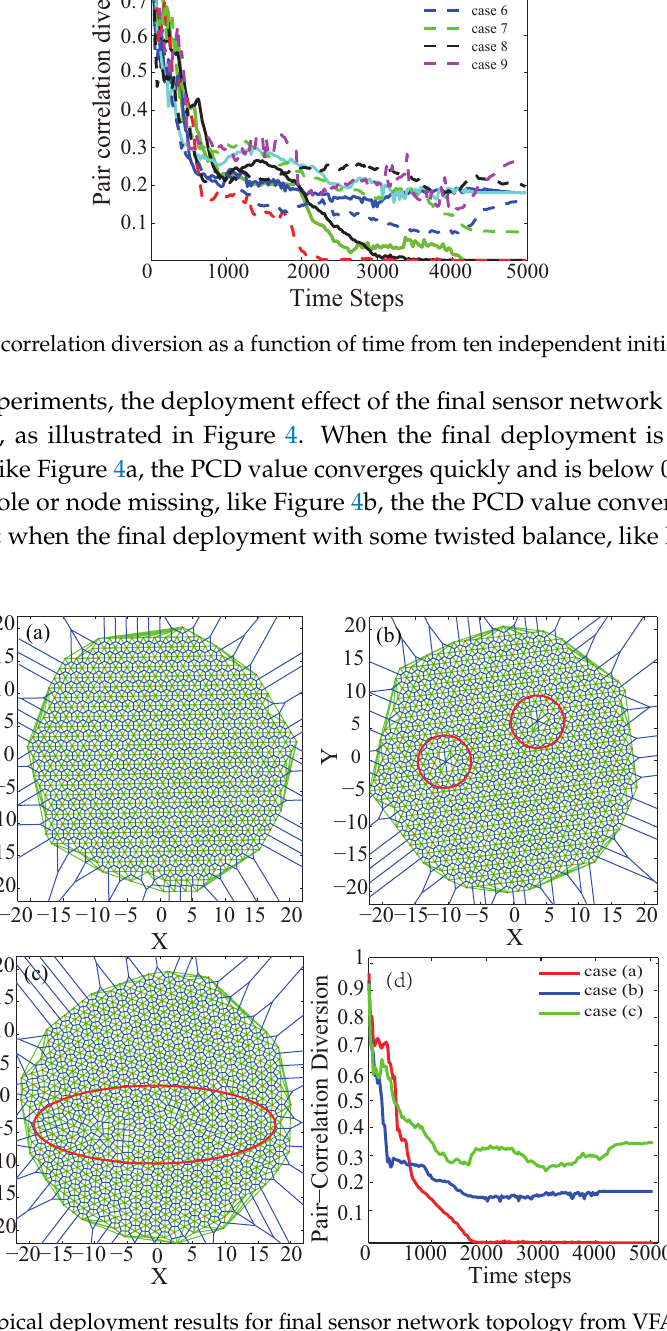
Figure 4. Three typical deployment results for final sensor network topology from VFA-SF: ( a ) perfect network to regular hexagon topology; ( b ) final network with hole marked by red circles; ( c ) final network with some twist balance marked by red ellipse; ( d ) corresponding PCD value of these three simulations